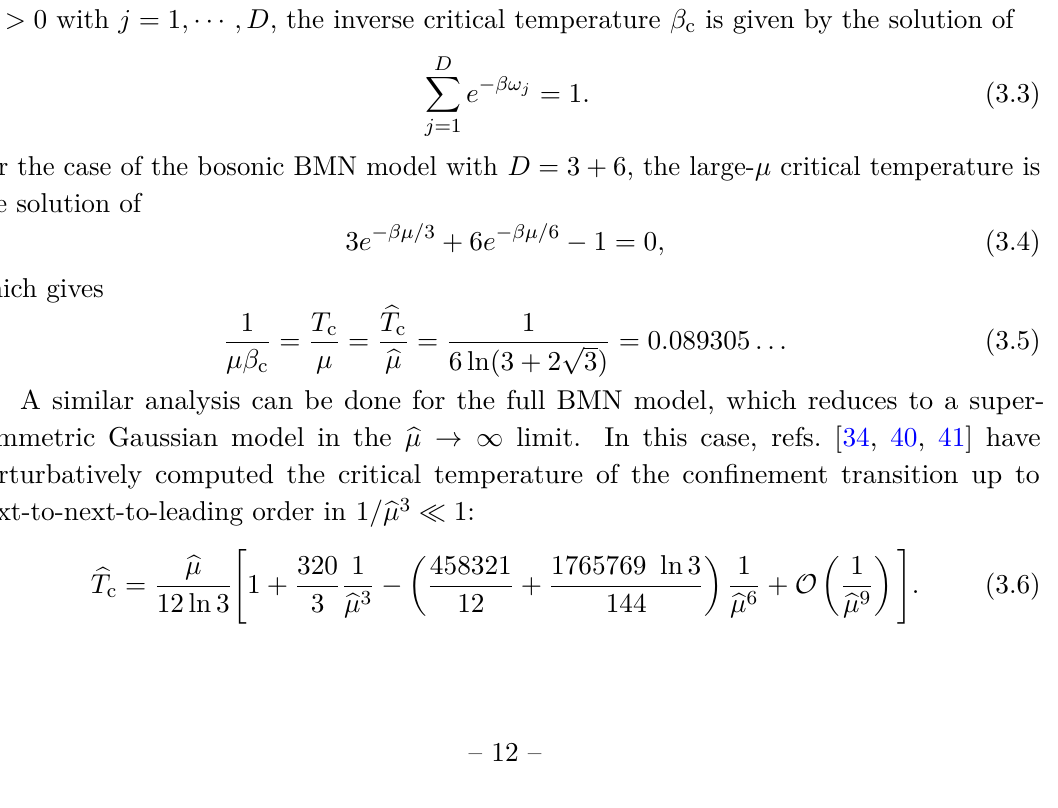
µ = 0 . 5 with N = 16 , 32 and 48 , b = 0 . 900(2) . A gap appears for b T = 0 . 905 > b T c becomes more uniform as N c